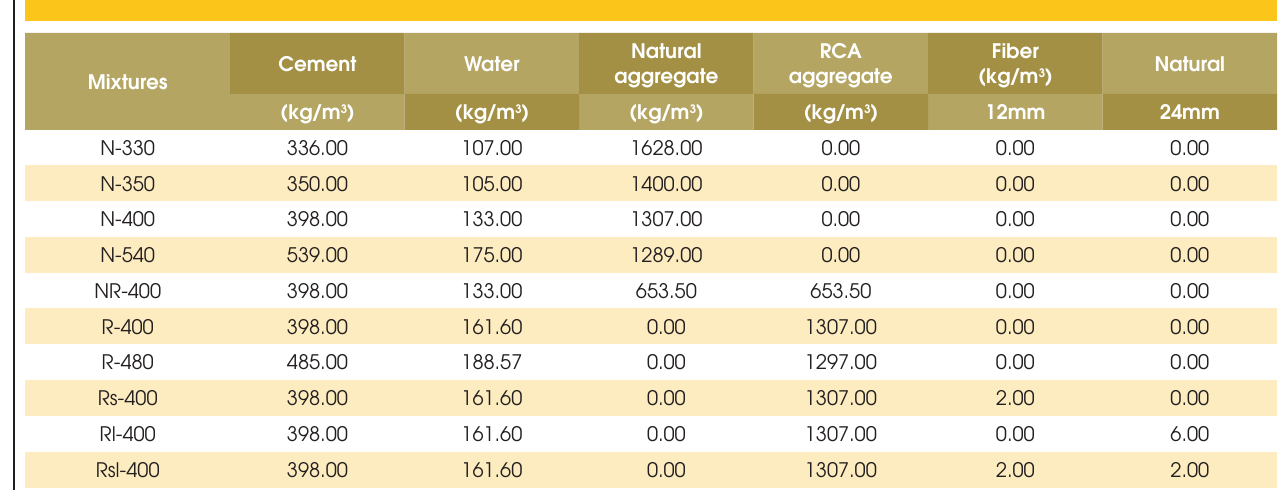
Table 3 – Mean compressive strength (f